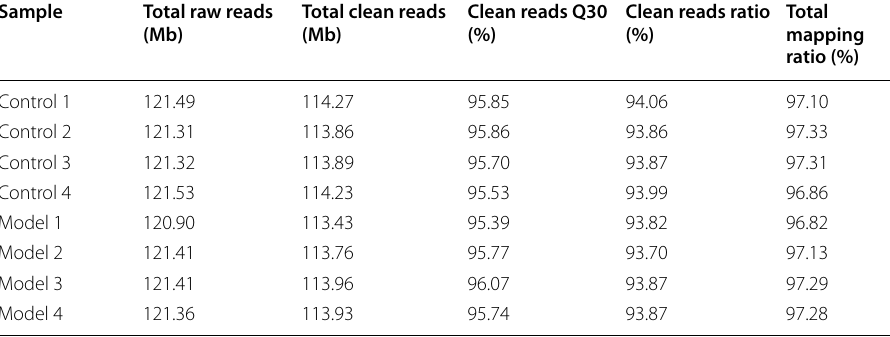
Table 1 Total reads and mapping ratio for control and model groups in RNA-seq Sample Total raw reads